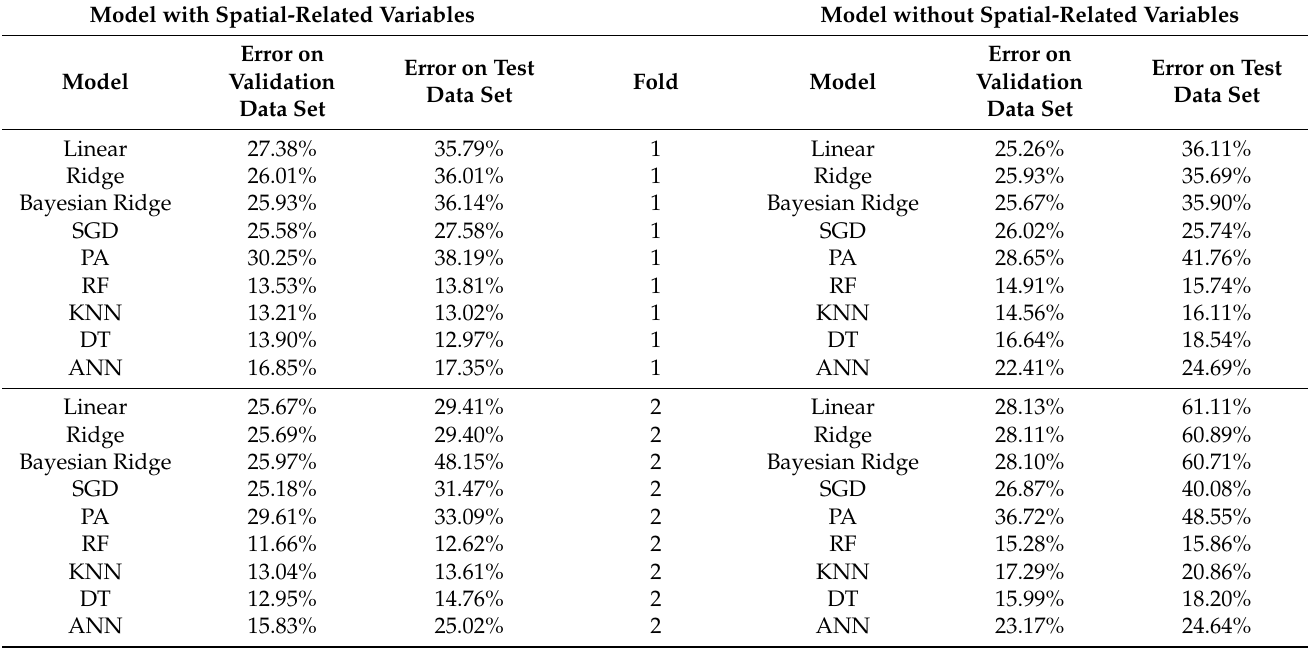
Table 8. Comparison of the models with and without spatial variables on various folds for the test and validation data set.